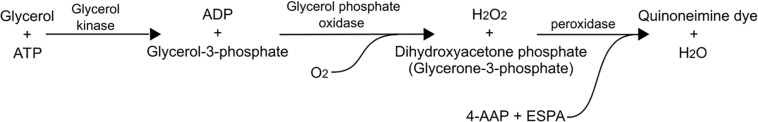
Possible use of glycerol phosphorylation to assess ATP.